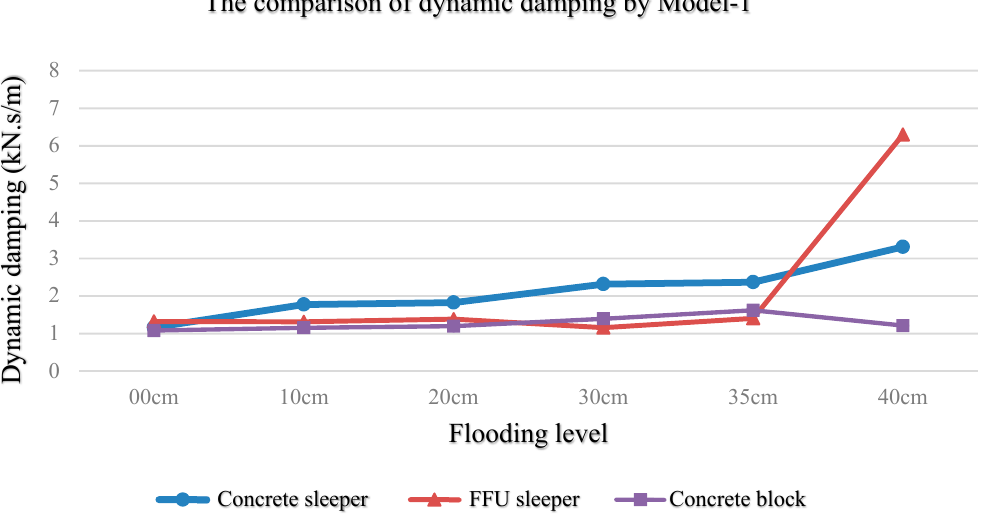
16 of 32 Figure 17. The relationship between dynamic stiffness and resonance frequency squares at different masses.